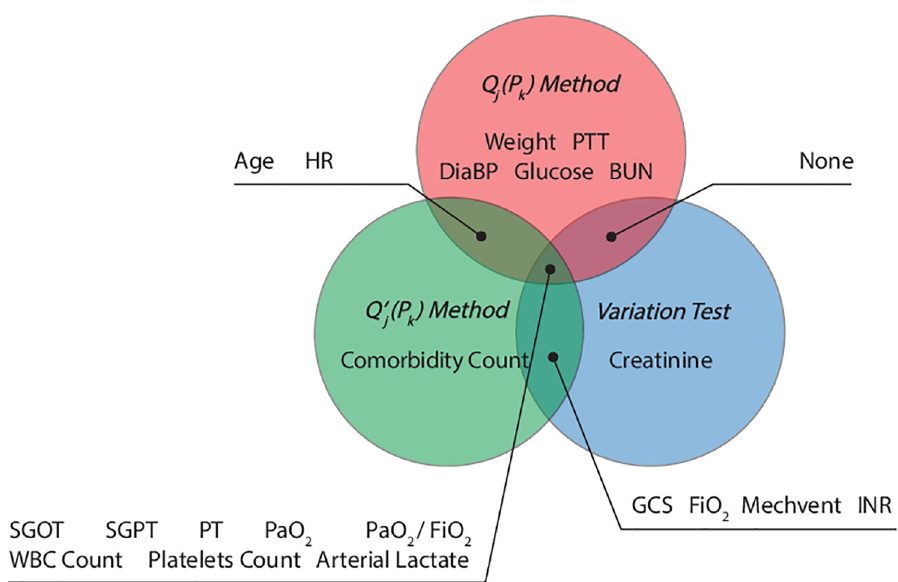
Fig 3. Visualization of the selected features (21 features in total) by Q j ( P K ), Q 0 ð P Þ , and Variation test . Q j ( P K ) K j calculates the discriminative power of feature i for a given clustering as the ratio of inter-cluster inertia to the total ð P Þ calculates the discriminative power of feature i as the ratio of inter-cluster inertia computed using feature i . Q 0 K j inertia computed using feature i to total inter-cluster inertia computed using all features. Variation test selects features that have the lowest probability of overlap across clusters (please see Methods section Feature selection methods [56] for more details). Note that there is a significant overlap between features chosen by these selection criteria. However, each criterion yields a distinct set of features significantly associated with different sepsis